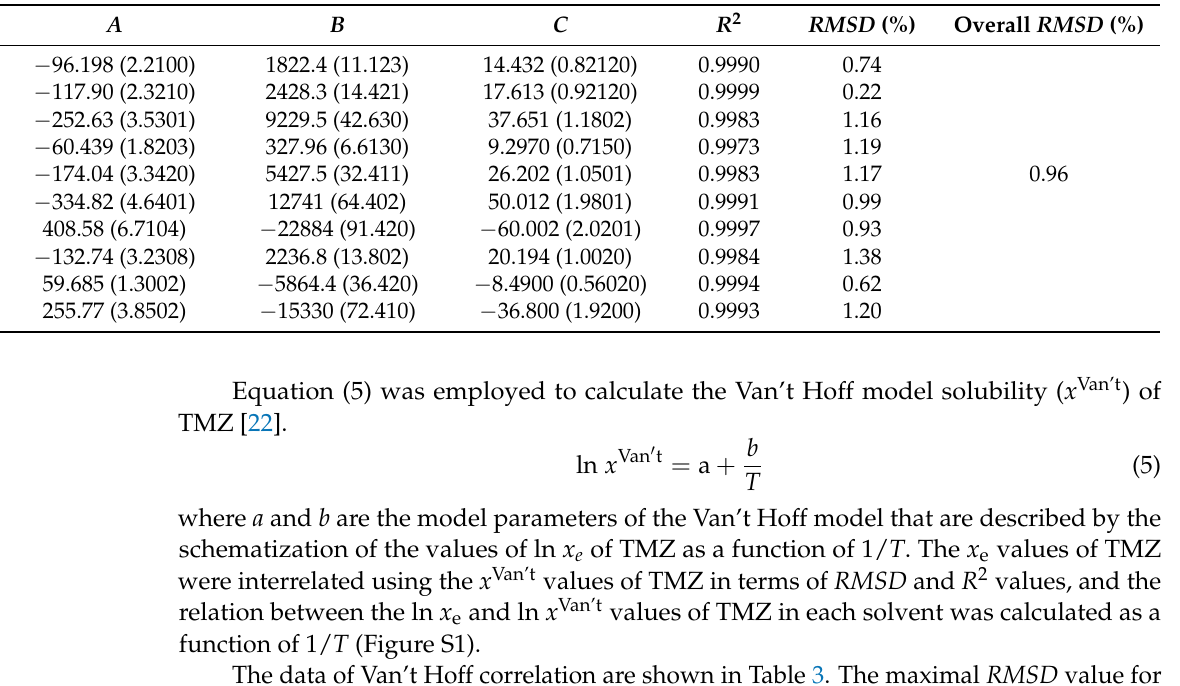
Table 2. Results of Apelblat model in terms of model parameters ( A , B and C ), R 2 and % RMSD values for TMZ in various solvents ( S ) (values in parentheses are standard deviations).